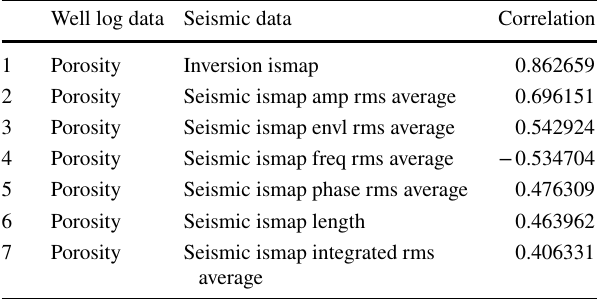
Table 11 Evaluation of different attributes in the third category